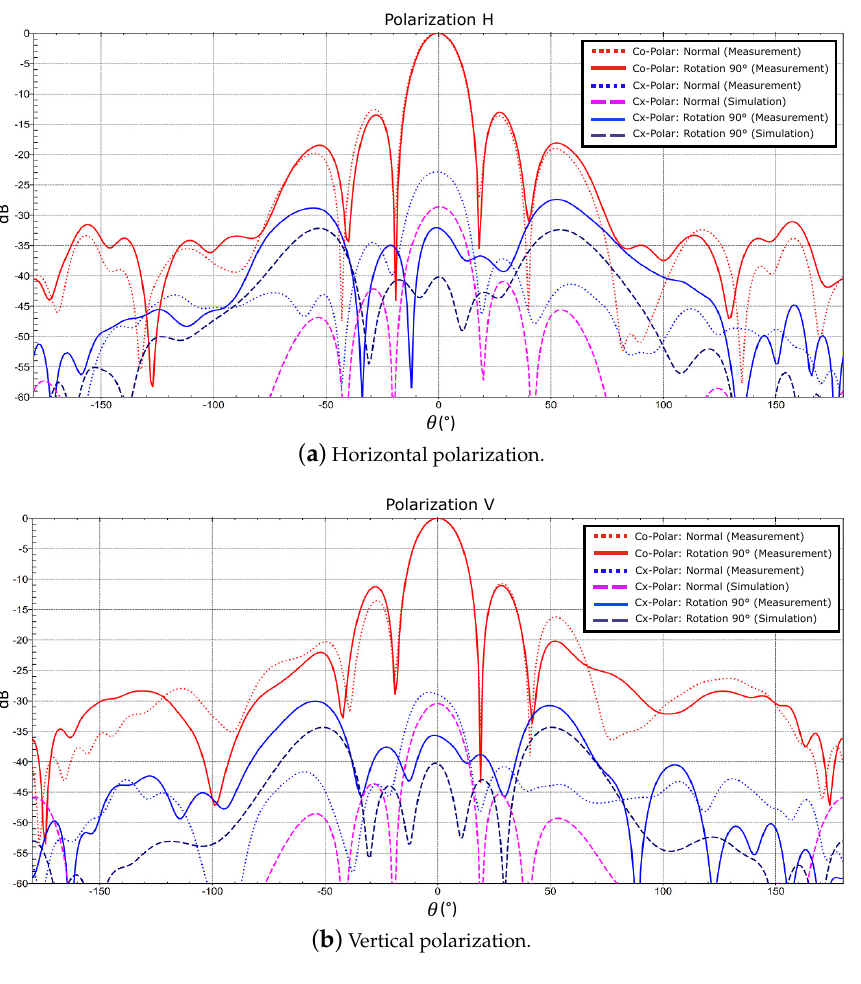
Figure 15. Comparison normal array and array with sequential 90° rotation @ f 0 = 1.325 GHz: normalized co-polar & cross-polar patterns ( ϕ = 90 ◦ ). Uniform amplitude and phase